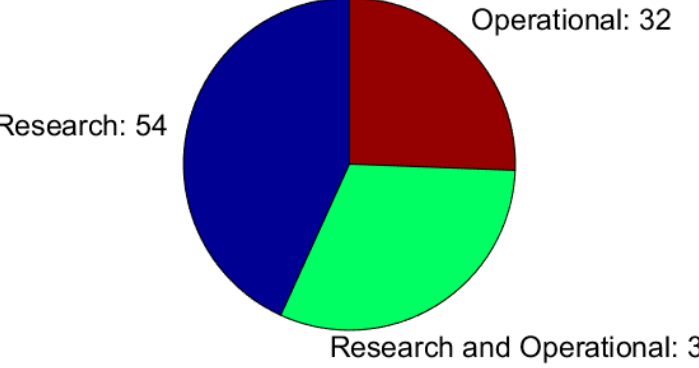
Figure 2. Purpose of the snow measurements, and number of respondents selecting them. The width of each slice of the pie represents the fraction of responses declaring ‘Research’, ‘Operational’, or both.